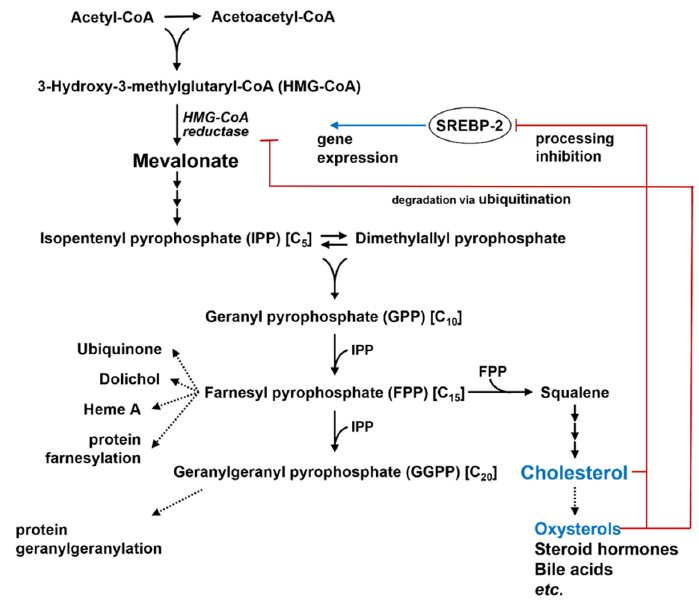
Figure 1. The major pathway for de novo cholesterol synthesis. Cholesterol is synthesized through the mevalonate-isoprenoid pathway. A series of isoprenoid products of this pathway play vital roles in multiple cellular functions. SREBP: sterol regulatory element-binding protein.